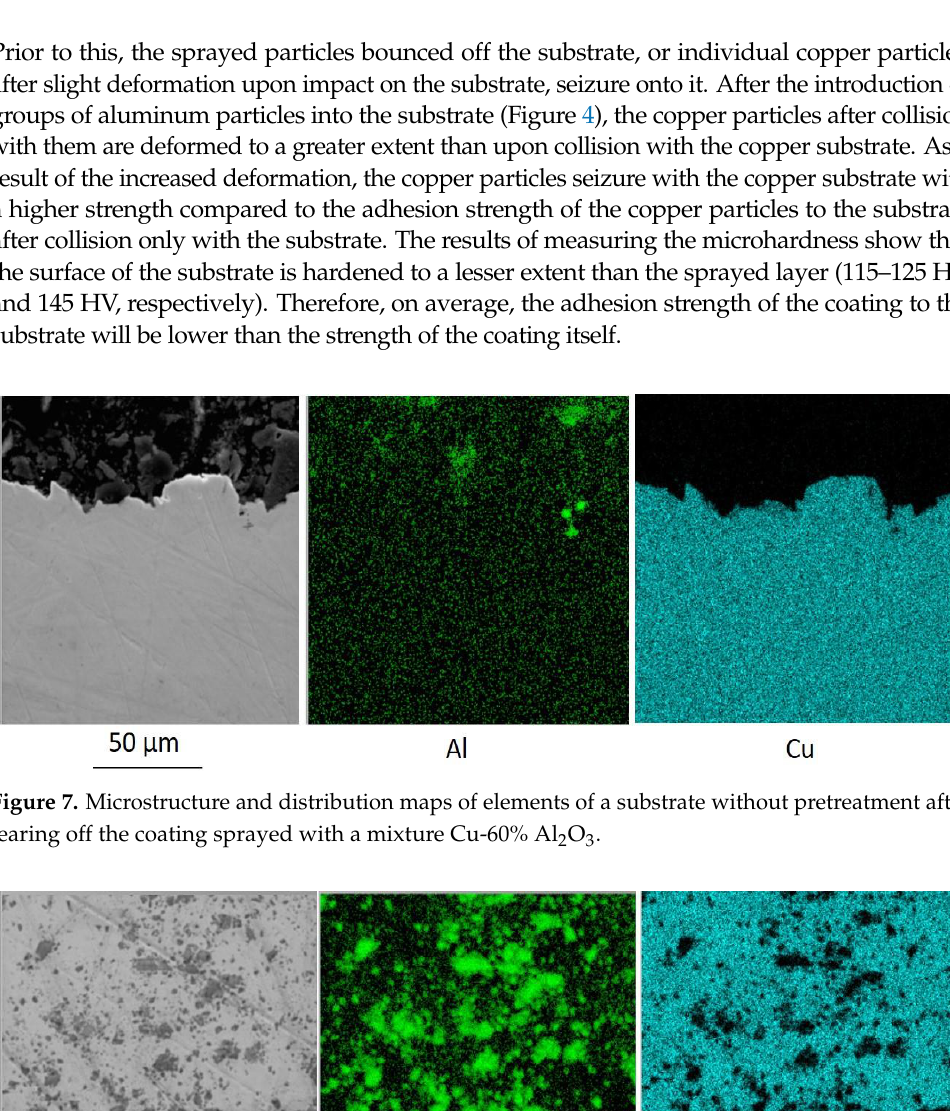
Figure 9. The microstructure and distribution maps of elements of the separation surface of the cold- sprayed 40% Cu-60% Al 2 O 3 without preprocessing. Based on the above microstructures and microhardness measurements, the adhesion of the coating when the powder mixture is sprayed onto the substrate without pretreat- ment can be represented in the following way. First, there is an introduction of groups of aluminum particles into the copper substrate (Figure 4). The penetration depth does not